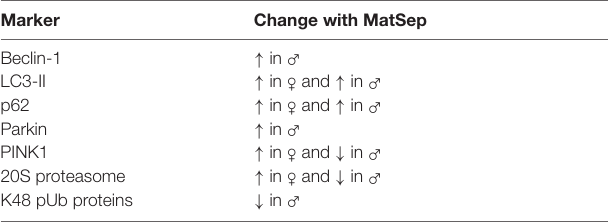
TABLE 1 | Significant changes in proteostasis marker expression that were seen in the hippocampus of adult rats exposed to MatSep.